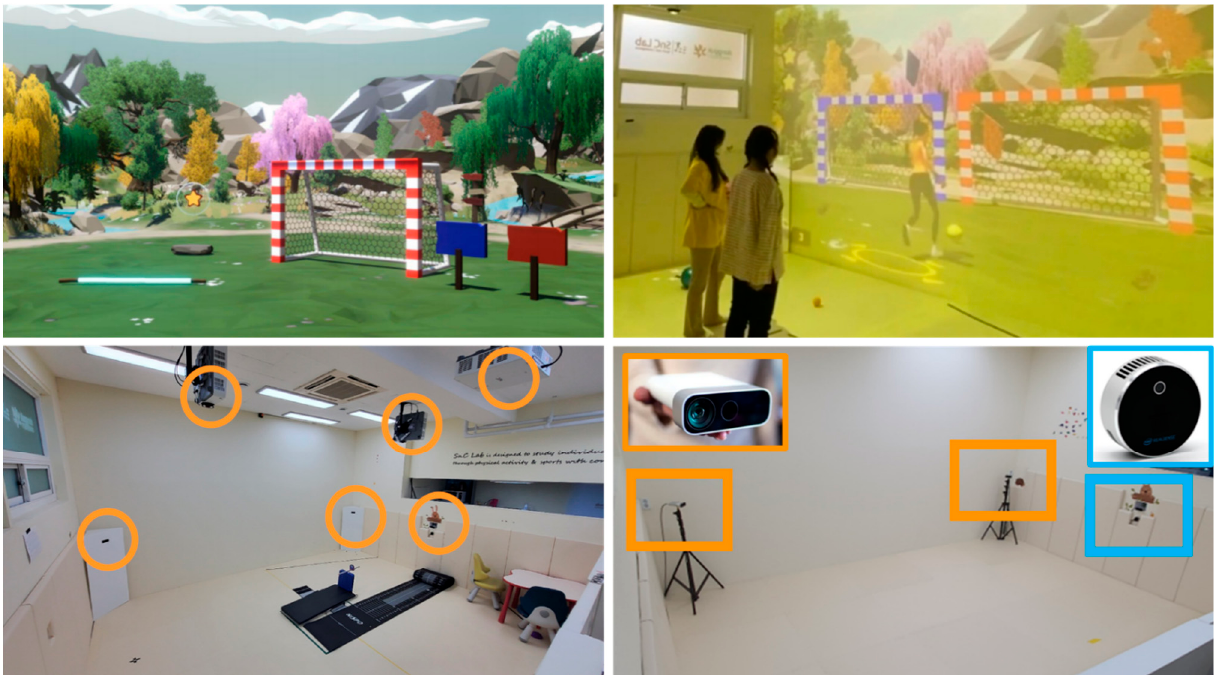
Figure 4. IoT-based virtual reality exercise system.